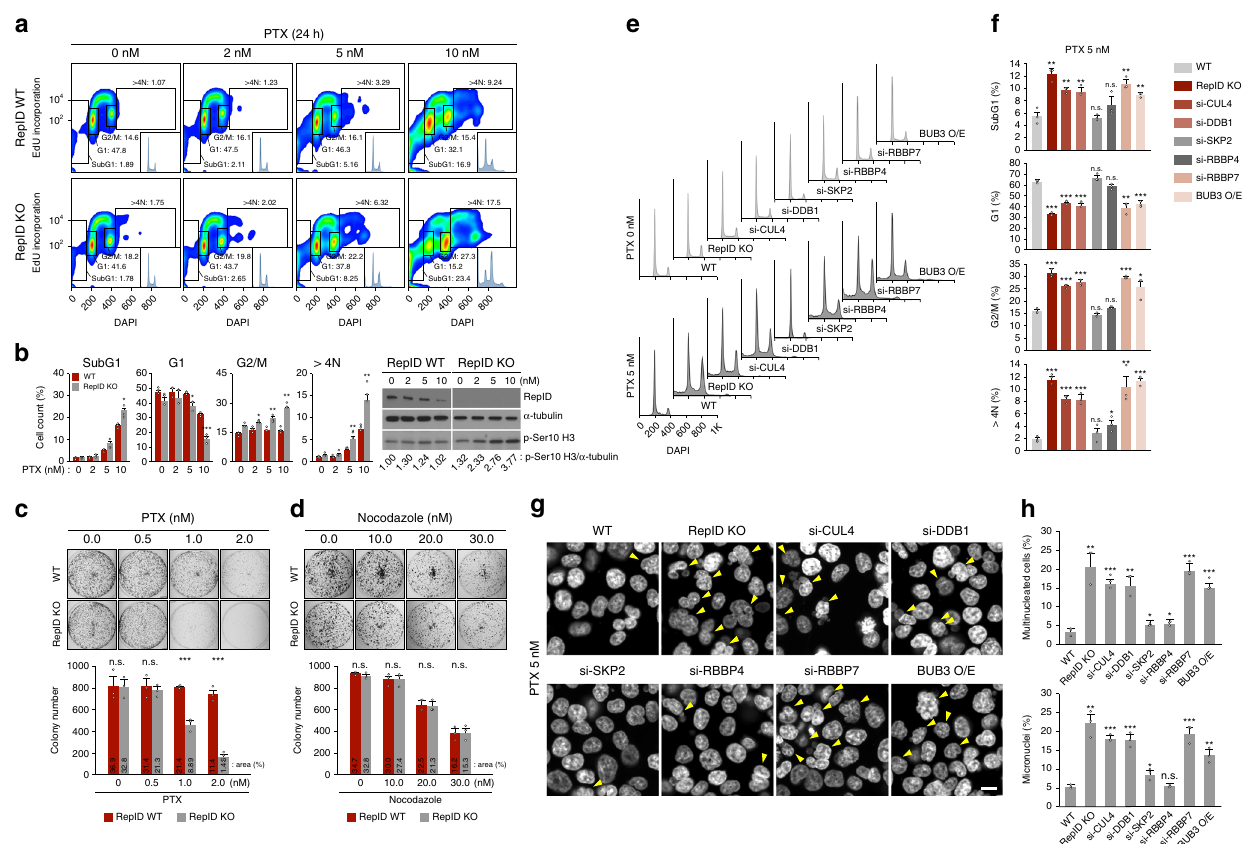
Fig. 5 RepID-de fi cient cells are more sensitive to paclitaxel. a Paclitaxel (PTX) treatment increases the prevalence of subG1, G2/M, and >4 N populations in RepID-de fi cient HCT116 cells. HCT116 RepID WT and KO cells treated with PTX for 24 h were labeled with EdU for 30 min prior to collection and analyzed by FACS. Percentage of each cell cycle phase was indicated in EdU-positive histogram plots (insets). b Bar graph depicting the cell cycle distribution of cells collected in a from three biologically independent experiments (left panel). Immunoblot analysis showing elevated accumulation of phosphorylated histone H3 in RepID-de fi cient cells in response to PTX treatment as in a (right panel). c Colony-formation assay with HCT116 RepID WT and KO cells upon PTX treatment. Bar charts indicate colony number, and the percentage of covered area is provided above the bars. d Nocodazole sensitivity is not changed by RepID de fi ciency. e – h Failure of RepID-CRL4 RBBP7 -based BUB3 degradation leads to increased sensitivity to PTX treatment. e Depleted/overexpressed HCT116 cells as indicated were treated with PTX and analyzed by FACS. Histogram indicates asynchronized (upper panel) or PTX-treated cells (bottom panel). f Percentage of cells in subG1, G1, G2/M, and >4 N phase in e . g Nuclear staining after PTX treatment in depleted/ overexpressed HCT116 cells as indicated. Red arrows indicate multinucleated cells. Scale bar: 10 μ m. h Percentage of multinucleated cells and micronuclei in g . Error bars in all results represent standard deviation from three independent experiments (* p value < 0.05, ** p < 0.01, *** p < 0.001, n.s. not signi fi cant, Student ’ s t (Fig. 6e, f). These observations suggested that BUB3 was pro- tected from degradation in RepID WT cells through its seques- tration in PML-NB during interphase. The effects of MG132 on BUB3 levels and distribution in PML- depleted RepID WT cells suggest that BUB3 might be a potential substrate for CRL4-mediated ubiquitination during interphase, unless it is protected by PML-NB. Consistent with this suggestion, the colocalization between BUB3 and CUL4A partially increased with exposure to MG132 (Supplementary Fig. 4g, RepID WT panel). CUL4A and BUB3 did not show colocalization in RepID KO cells, regardless of PML levels or MG132 treatment (Supplementary Fig. 4g, RepID KO panel). BUB3 proteins contain a PIP-like motif that is highly conserved across species, suggesting that, in PML-depleted cells, BUB3 might be ubiquitinated by PCNA-based CRL4 CDT2 (Supplemen- tary Fig. 4h). As shown in Supplementary Fig. 4i, co-IP experiments indeed con fi rmed that CRL4 CDT2 interacts with BUB3 on chromatin during S phase in PML-depleted cells. Direct the presence of PML-NB (Fig. 6g, lanes 1 – 4) but was